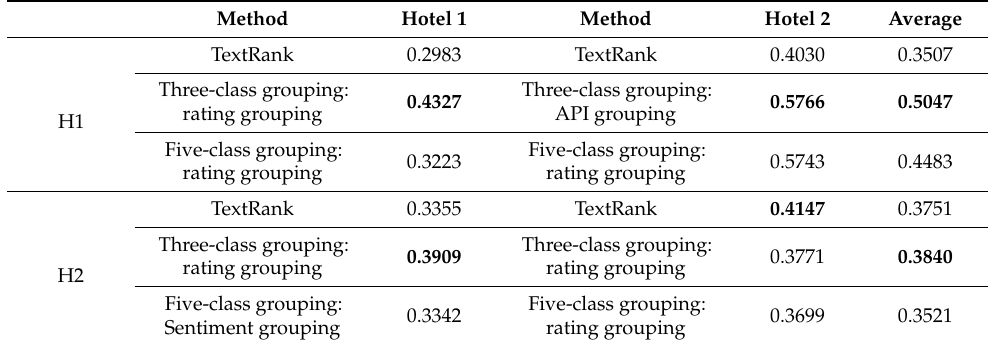
Table 10. Summary of the best BLEU scores achieved for both hotels.